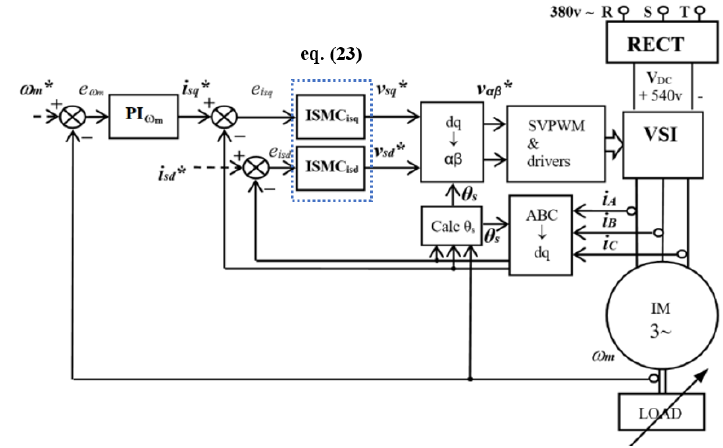
Figure 1. Block diagram of the proposed scheme.